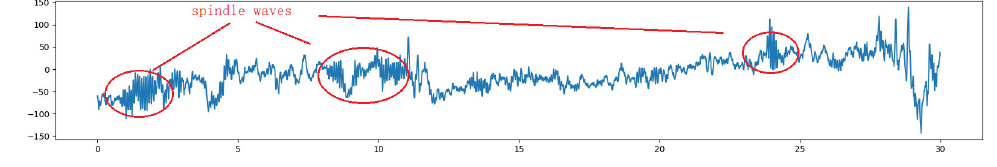
Figure 1. Three spindle waves of N2.